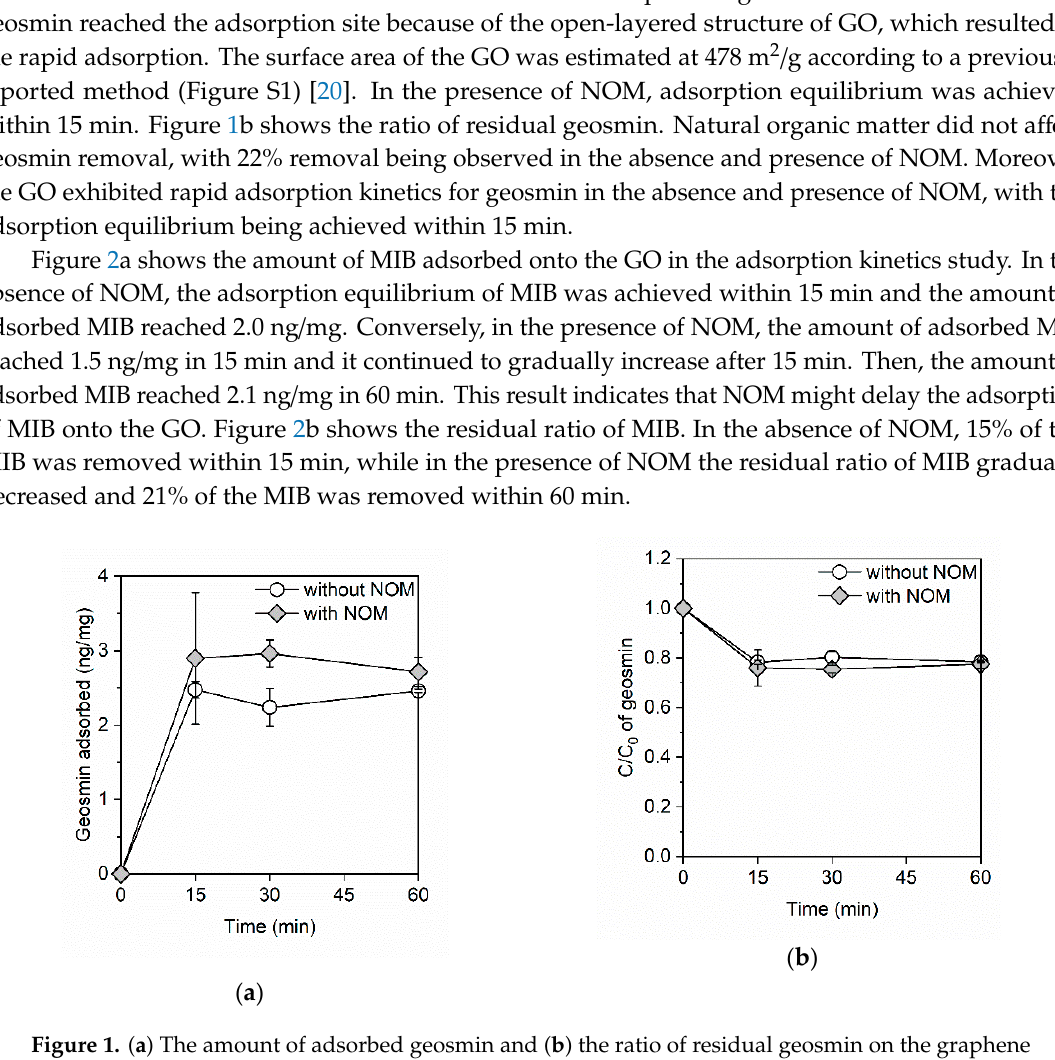
Figure 1. ( a ) The amount of adsorbed geosmin and ( b ) the ratio of residual geosmin on the graphene oxide (GO) in the absence and presence of natural organic matter (NOM). The GO and NOM concentrations were 100 mg/L and 3.6 mg C/L, respectively. The initial concentration of geosmin was ∼ 1 μ g/L and the initial pH was between 7.4 and 7.5.